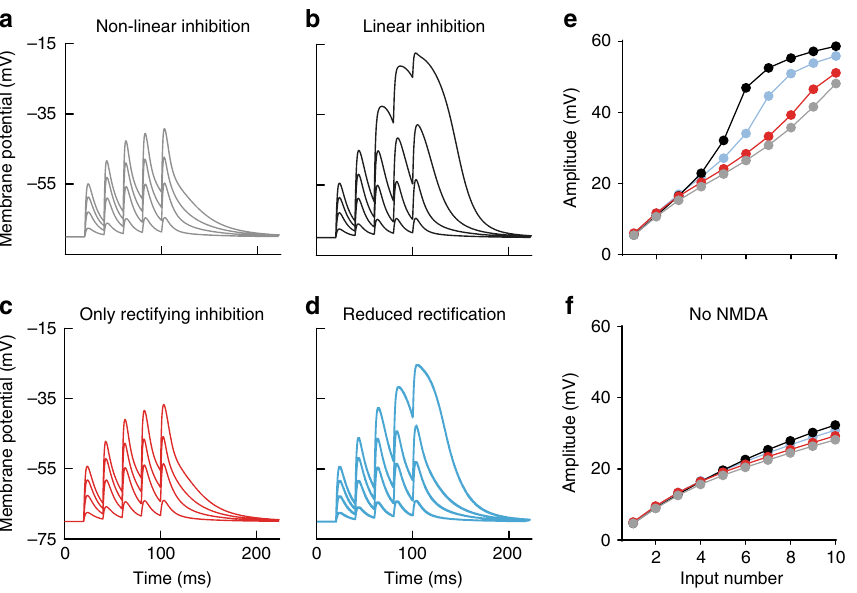
Fig. 6 Nonlinear outward recti fi cation of GABARs effectively counterbalances NMDAR activation in a dendritic branch model. a Family of voltage traces of burst activation of an increasing number of glutamatergic inputs (1, 3, 5, and 7; 0.14 nS each) in the presence of one GABAergic SOM-like model synapse that exhibits nonlinear outward recti fi cation as observed experimentally (Supplementary Fig. 4; 0.28 nS at rest, 0.7 nS max). b Responses to the same stimulation when the GABAR conductance did not show a voltage-dependent increase and was constant (0.28 nS). c Responses when only the outward- rectifying conductance of the GABAR was active (0.14 nS at rest, 0.56 nS max). d Responses when the outward-rectifying conductance of the GABARs was reduced by 50% (0.21 nS at rest, 0.42 nS max). e The dependence of the peak burst amplitude on glutamatergic input number. Note the near-linear increase of the burst amplitude for nonlinear inhibition and the strongly nonlinear behavior for reduced or removed outward recti fi cation of inhibition. f Dependence of the peak burst amplitude on input number when only AMPARs were present in the glutamate